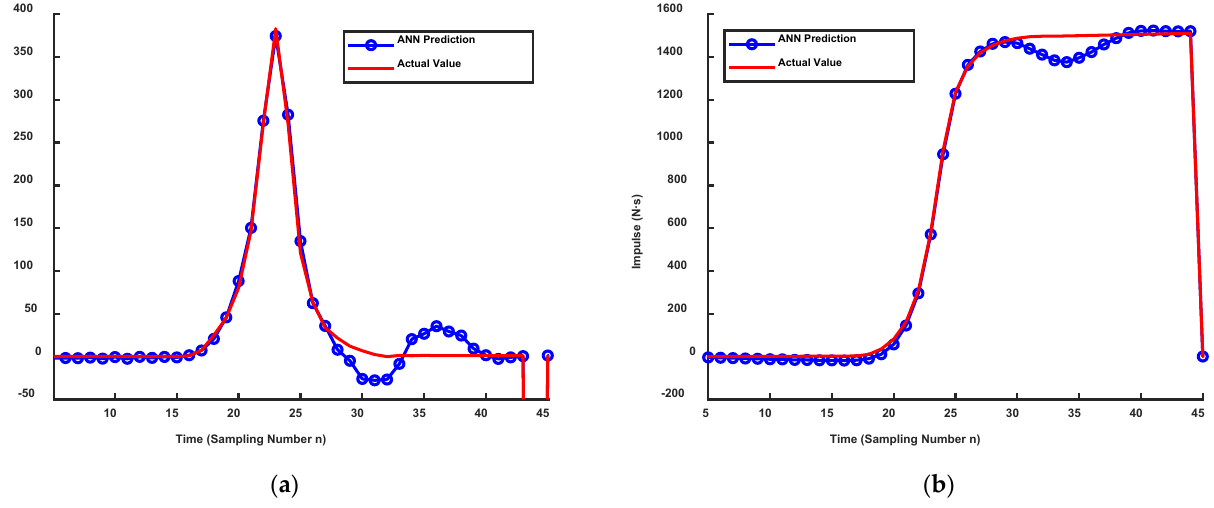
Figure 15. ( a ) The identification results of the load–time history. ( b ) The identification result of the impulse–time history.